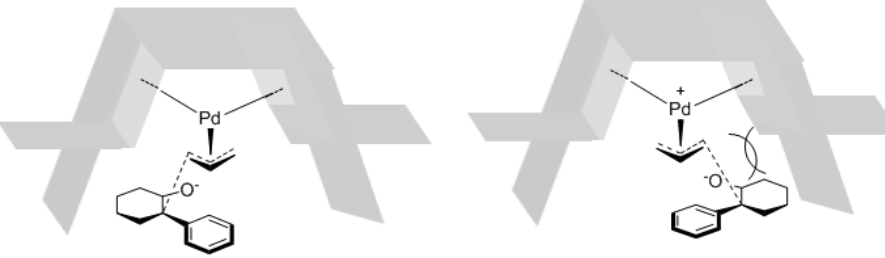
Figure 1. Illustration of chiral recognition during nucleophilic enolate addition. Reprinted with permission from Reference [31].